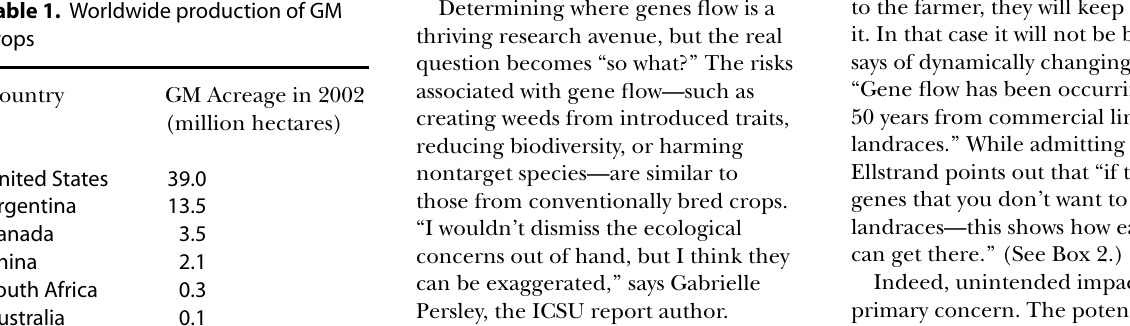
Table 1. Worldwide production of